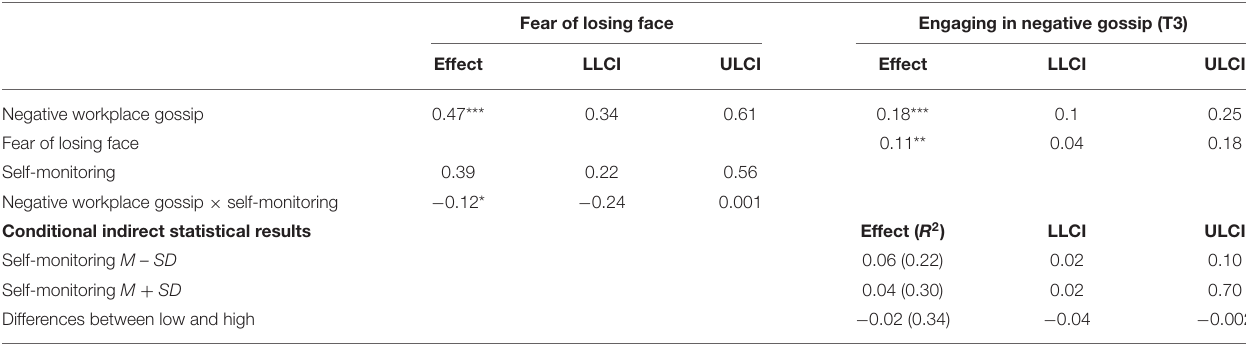
TABLE 5 | Supplementary regression results (without control variables).